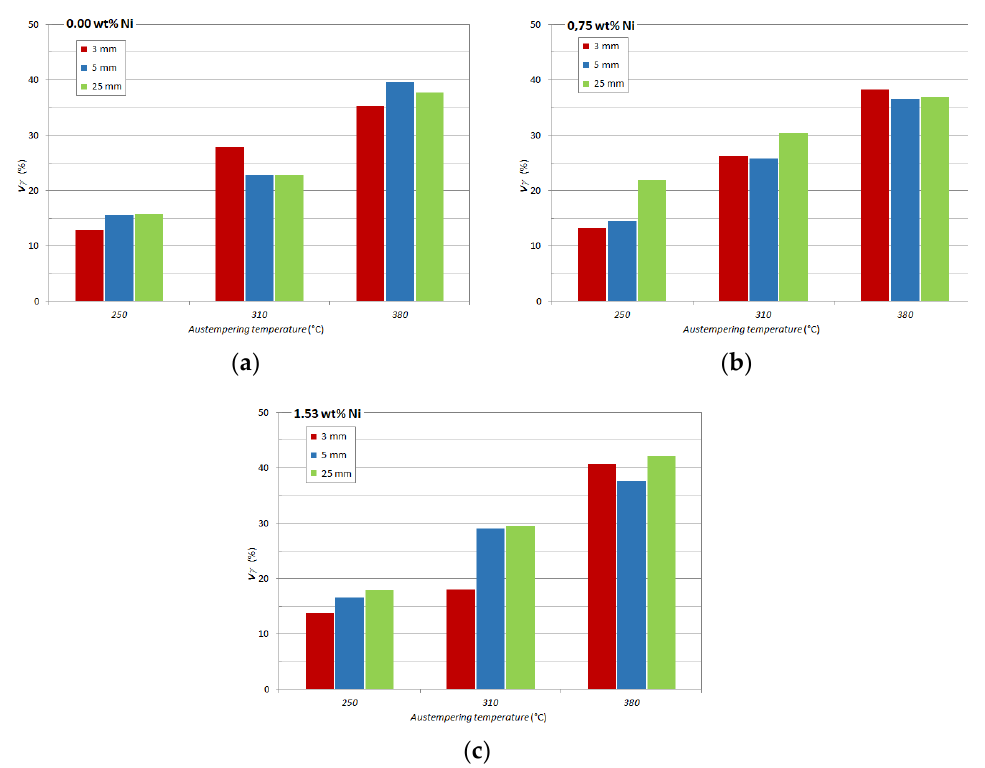
Figure 9. Austenite volume fraction V γ vs. austempering temperature (250 °C for 6 h, 310 °C for 3 h and 380 °C for 1 h); ( a ) 0.00 wt% of Ni; ( b ) 0.75 wt% of Ni; ( c ) 1.53wt% of Ni.